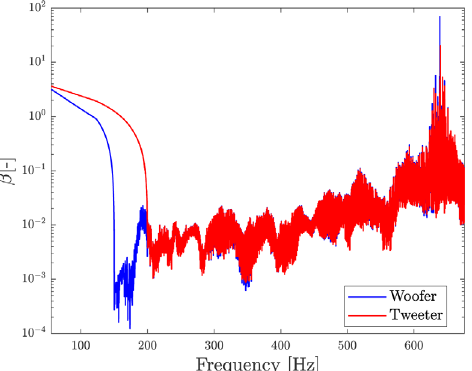
Figure 9. Variation in the b coef fi cients for one woofer and one tweeter as a function of the fi fth engine order frequency.